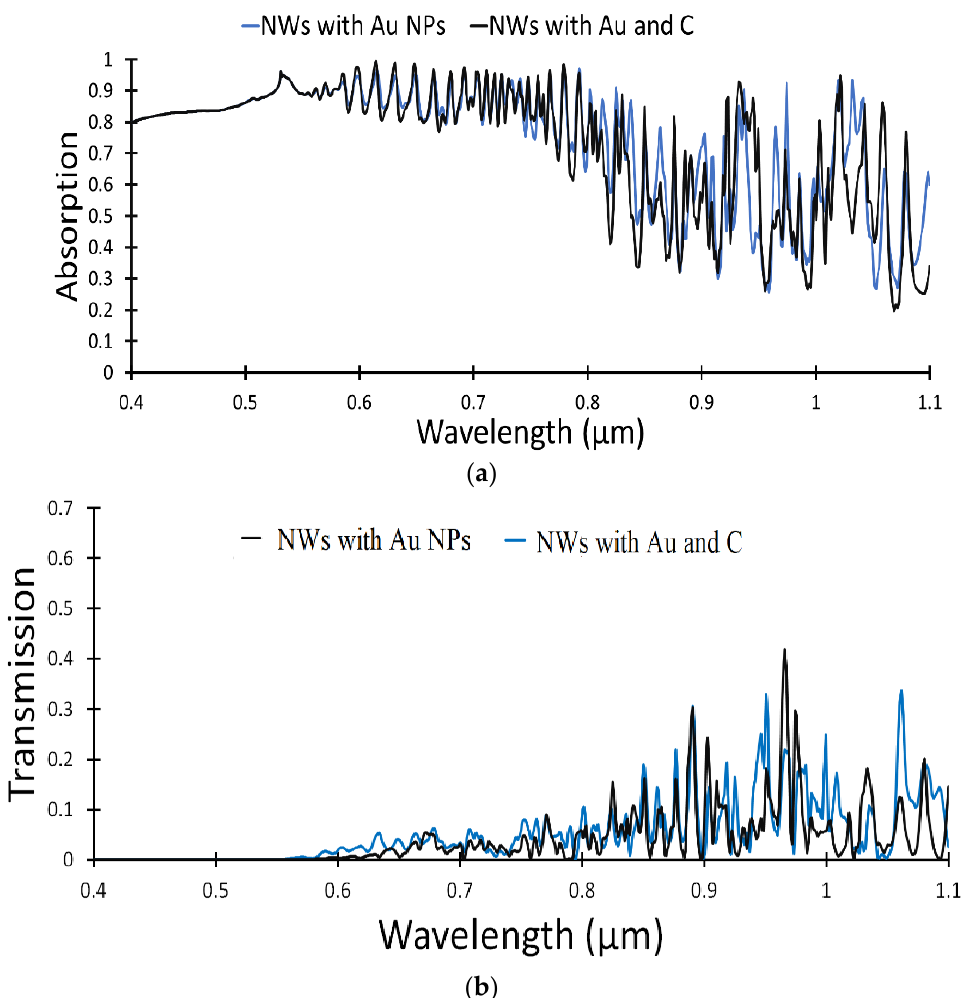
Figure 3. ( a ) Absorption and ( b ) transmission of the main two structures: SiNWs with Au NPs distributed on the substrate and SiNWs with graphene layer and Au NPs.